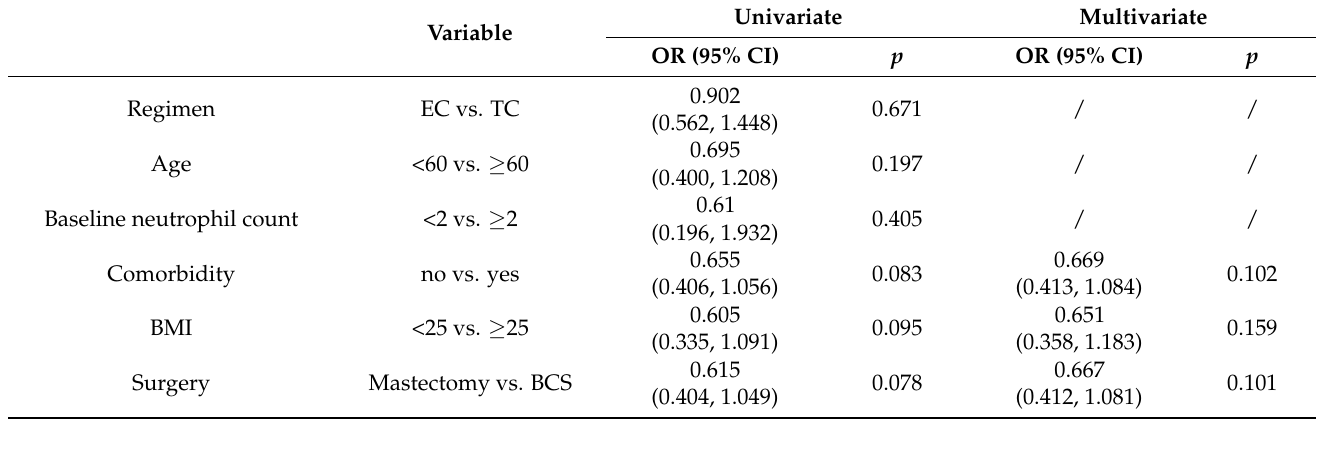
Table 5. Univariate and multivariate analysis results for potential predictors of grade 3 or 4 neutropenia.